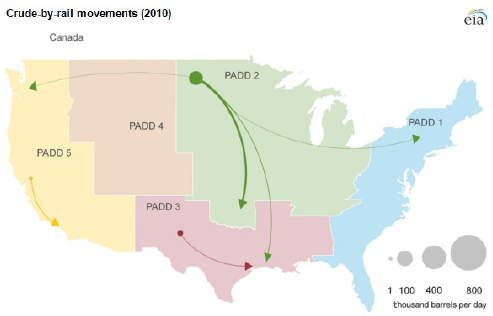
Figure 4. Crude ‐ By ‐ Rail Movements of Bakken and dilbit in 2010, tracked by Petroleum Administration for Defense District (PADD) regions [43].